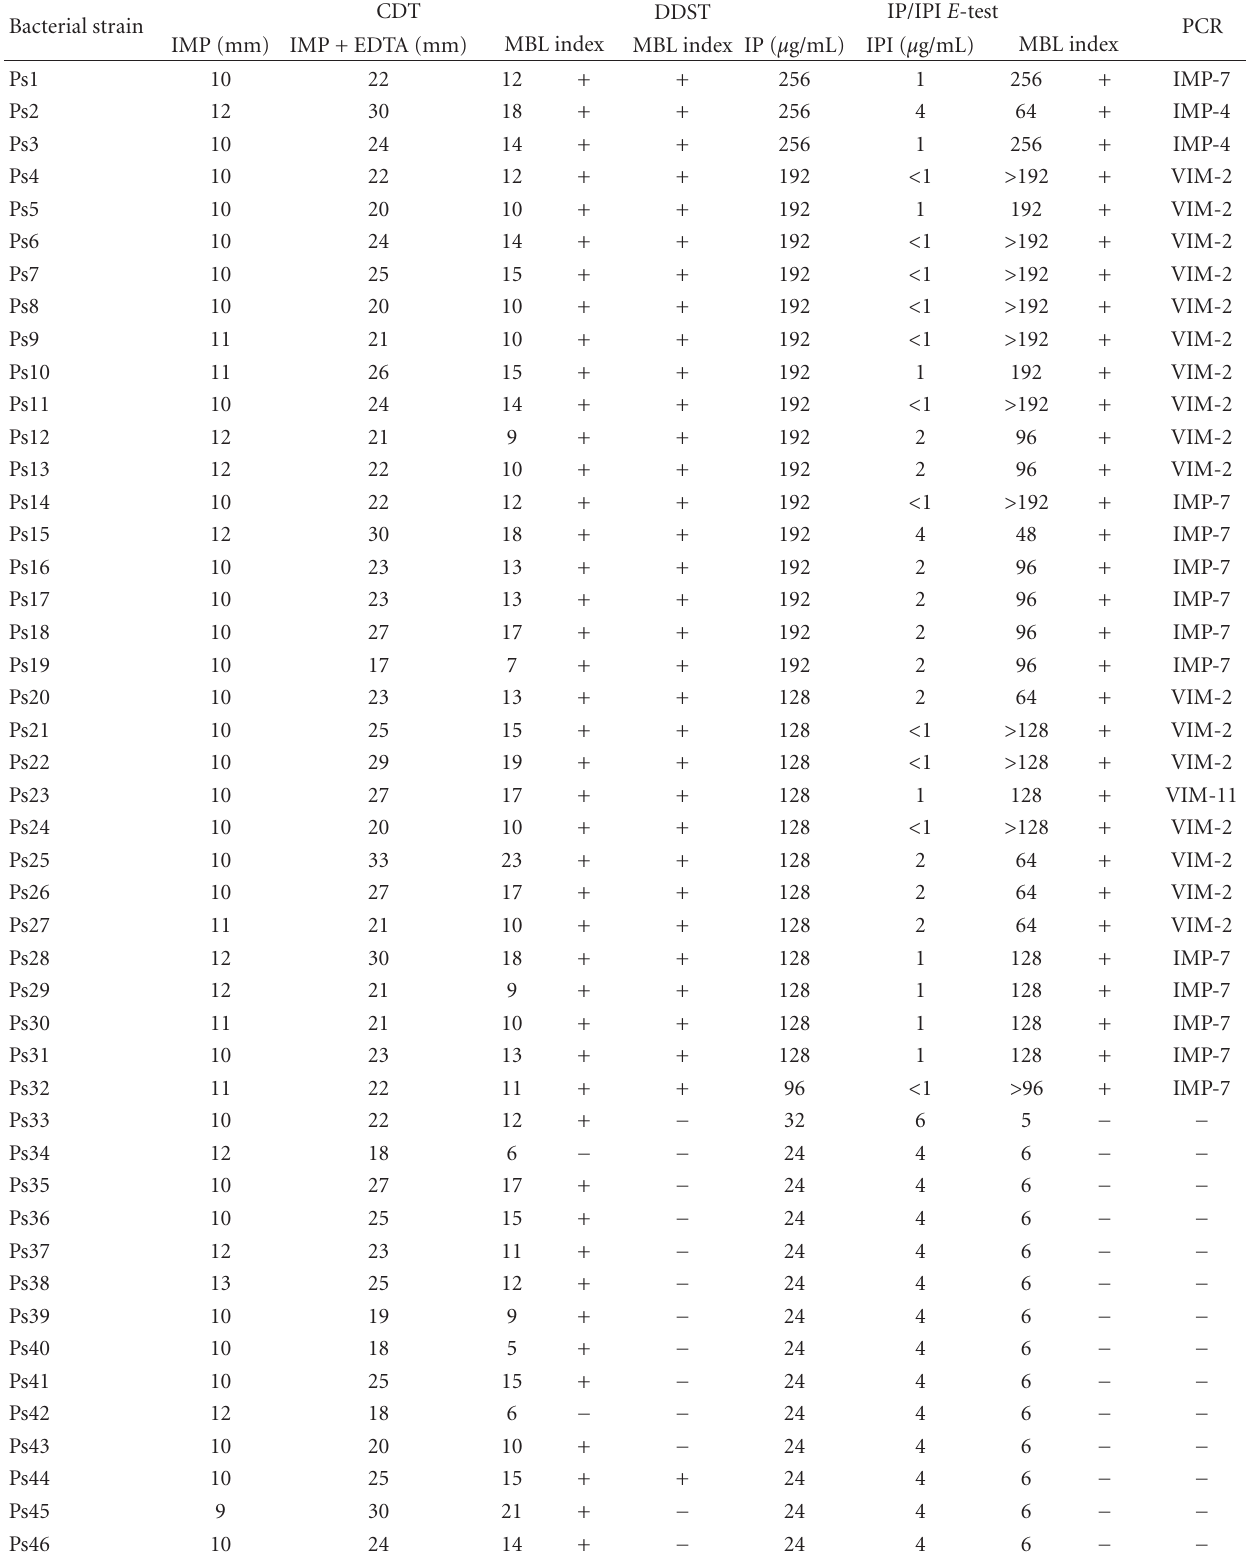
Table 1: Detection of MBL activity and MBL genes of IRPA clinical isolates from